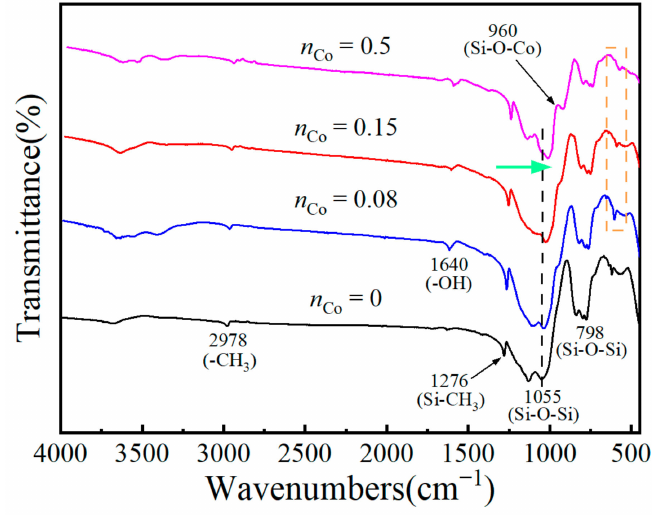
Figure 4. FTIR spectra curves of unsupported Co/MSiO 2 materials with various n Co calcined in N 2 atmosphere at 400 ◦ C (the green arrow represents the direction in which the Si − O − Si bonds centered at 1055 cm − 1 moves; the dotted rectangle emphasizes the peaks at 571 and 664 cm − 1